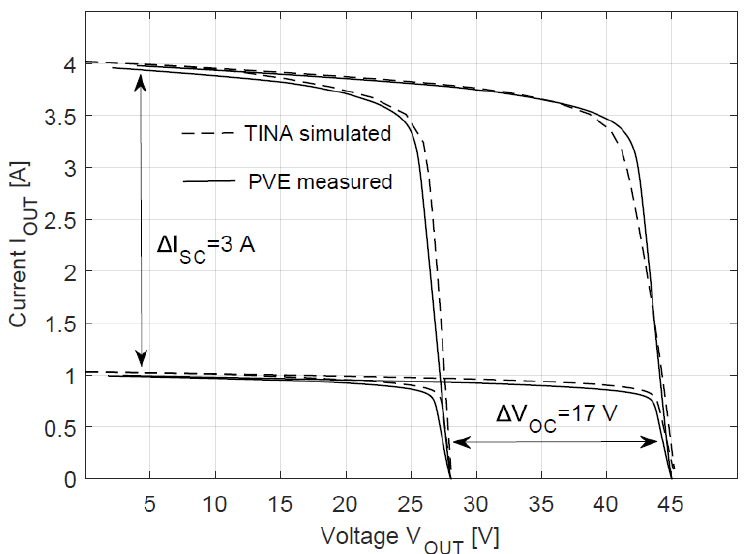
Figure 9. Simulation (dashed line) and measurements (solid line) results for the assumed values of currents I OUT (I SC ) and voltages V OUT (V OC ).